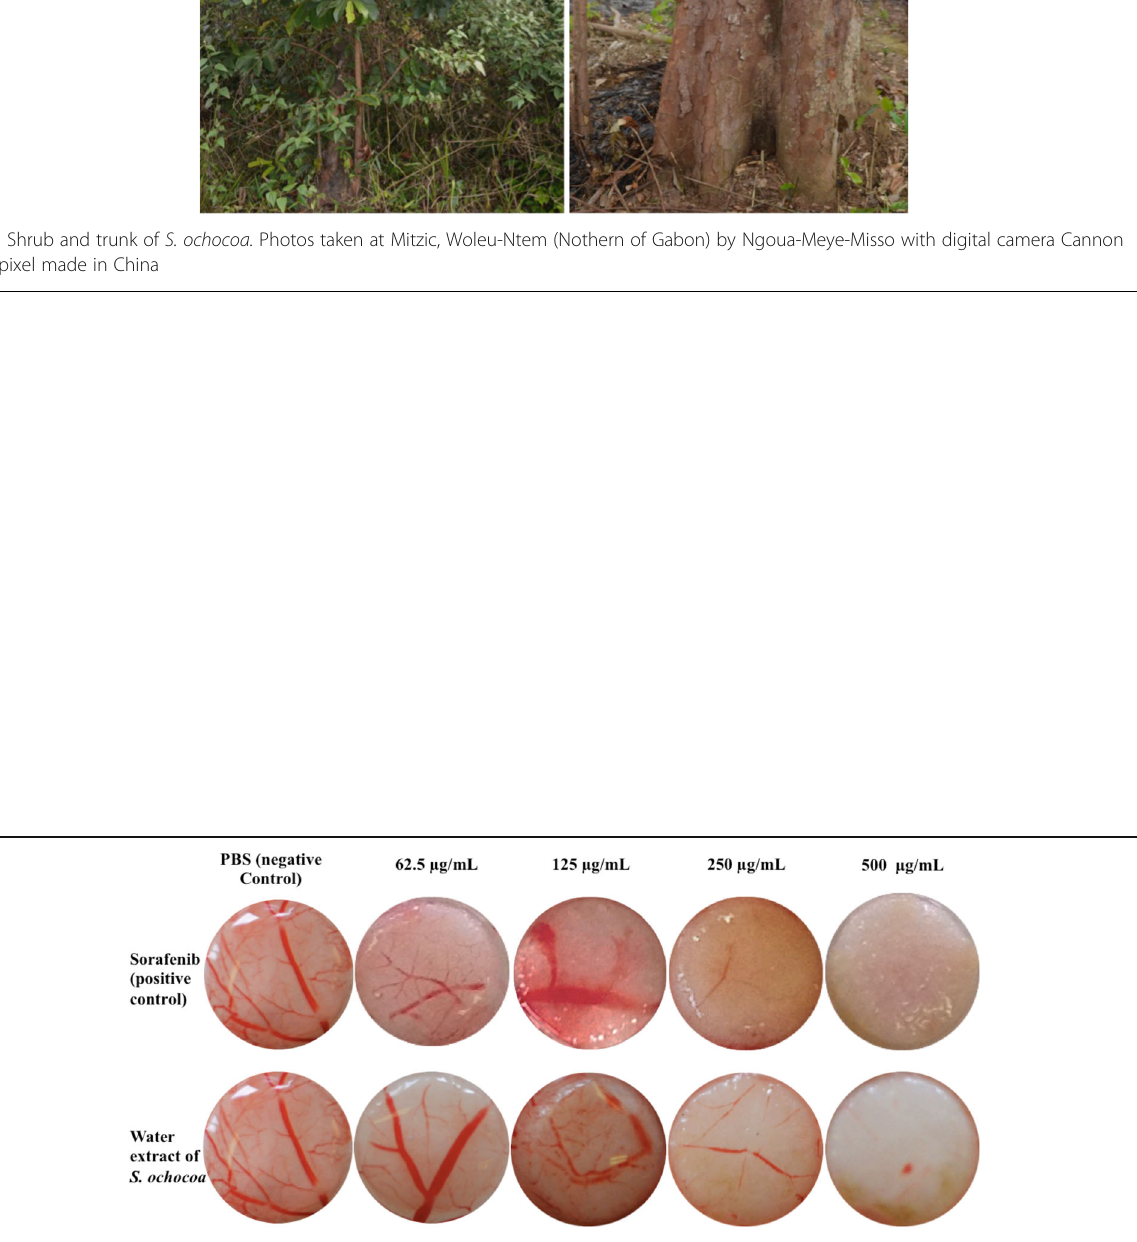
Fig. 2 Inhibitory effects of water extracts of plants on angiogenesis. The CAM of a 8 days old chick embryo was separately exposed to PBS (control). Extracts were introduced on top of the CAMs. After 48 h of incubation, the CAM tissue directly beneath each filter disk was resected, and digital images of the CAM sections were